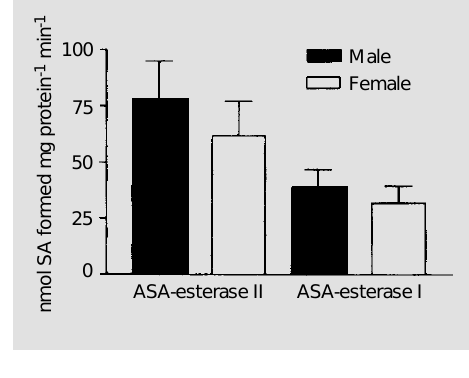
Figure 2 - ASA-esterases I and II activities in kidney homogenates from male and female mice. The final ASA concentration in the assay was 8 mM. Results are reported as mean ± SD. N = 5 for all groups. Student t -test, *P<0.0002,